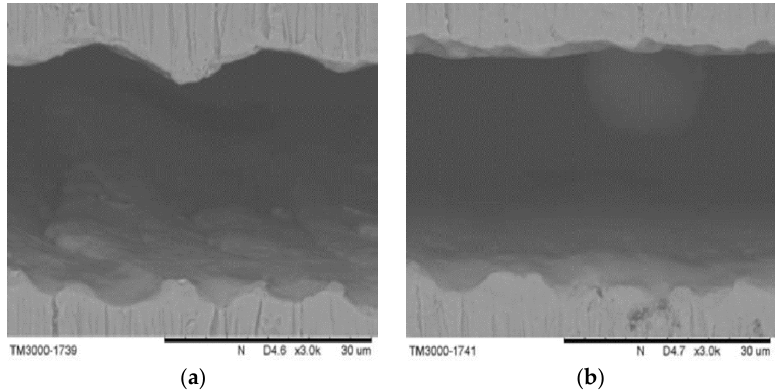
Figure 12. Scanning electron microscope (SEM) pictures of ( a ) poor and ( b ) good laser cutting